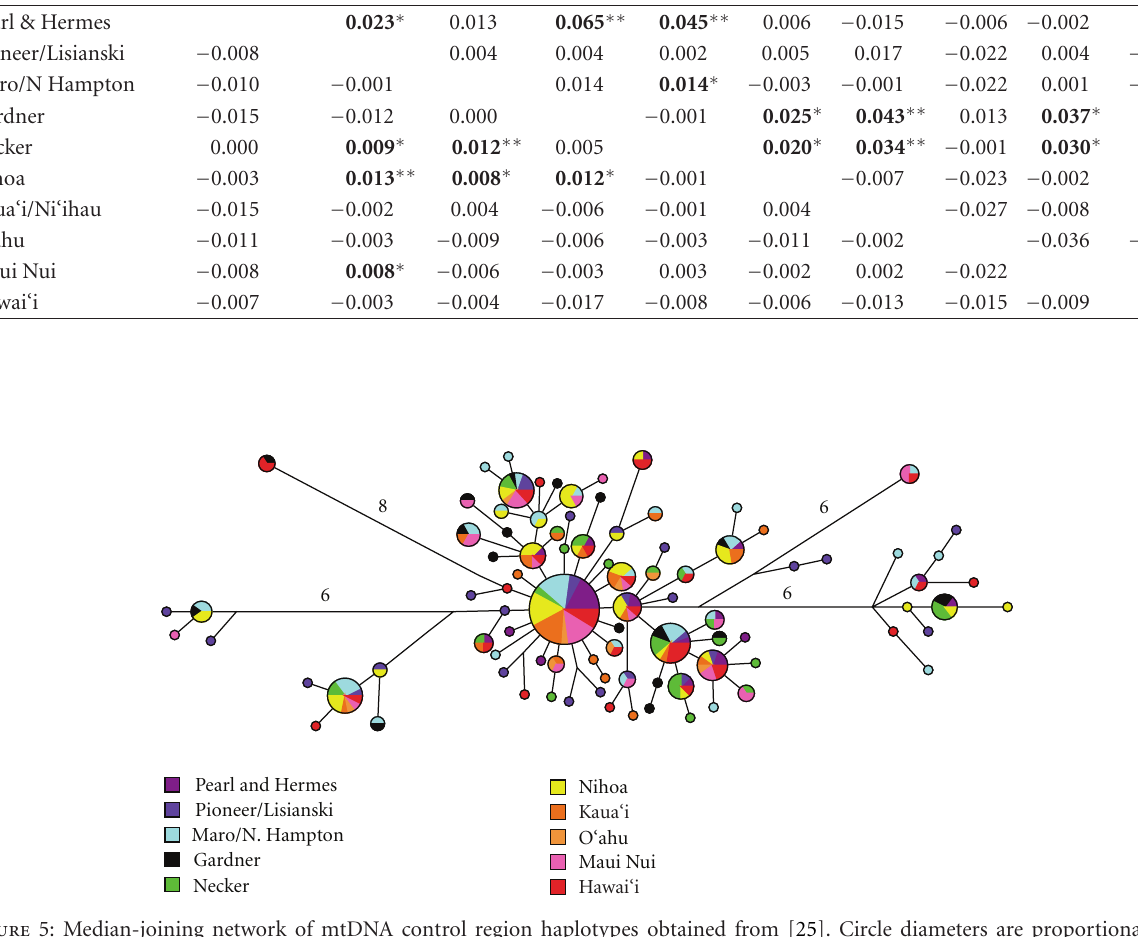
Figure 5: Median-joining network of mtDNA control region haplotypes obtained from [25]. Circle diameters are proportional to the frequency of the haplotype, and lines are proportional to the number of mutations separating haplotypes. Lines that represent greater than two mutations are